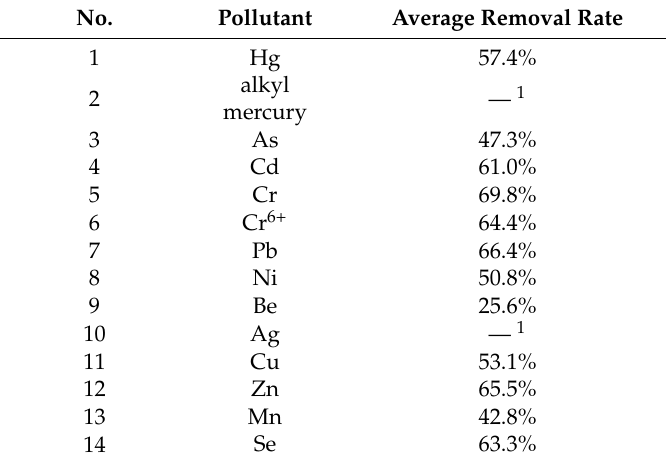
Table 4. Removal rates of heavy metals in WWTPs of